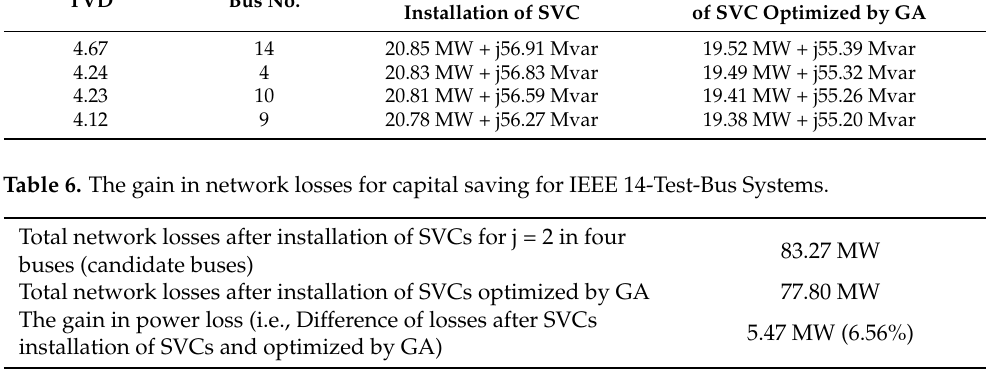
Table 5. Minimization of network loss for IEEE 14-Test-Bus Systems (after SVC installation). Network Losses after TVD Bus No. Installation of SVC